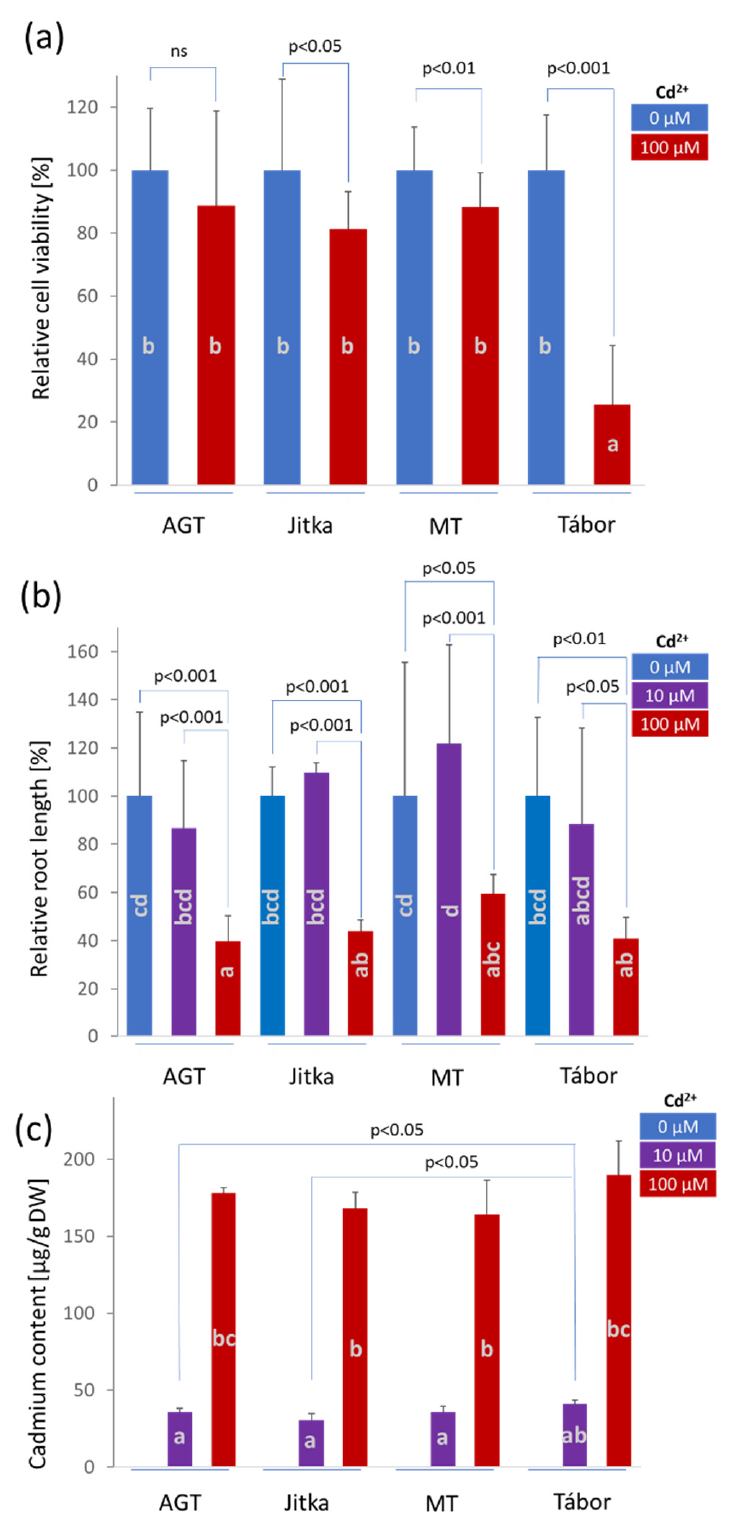
Figure 1. Cadmium tolerance in four genotypes employed in the study. ( a ) Relative cell viability of suspension cultures, ( b ) root length, and ( c ) cadmium content in shoots of six-day-old flax seedlings. The plots represent the means and standard deviation of at least five ( a , b ) and three ( c ) biological replicates. Different letters indicate significant differences (Kruskal-Wallis test, p < 0.05); p -values represent results of pair-wised comparisons and Student’s t -test.